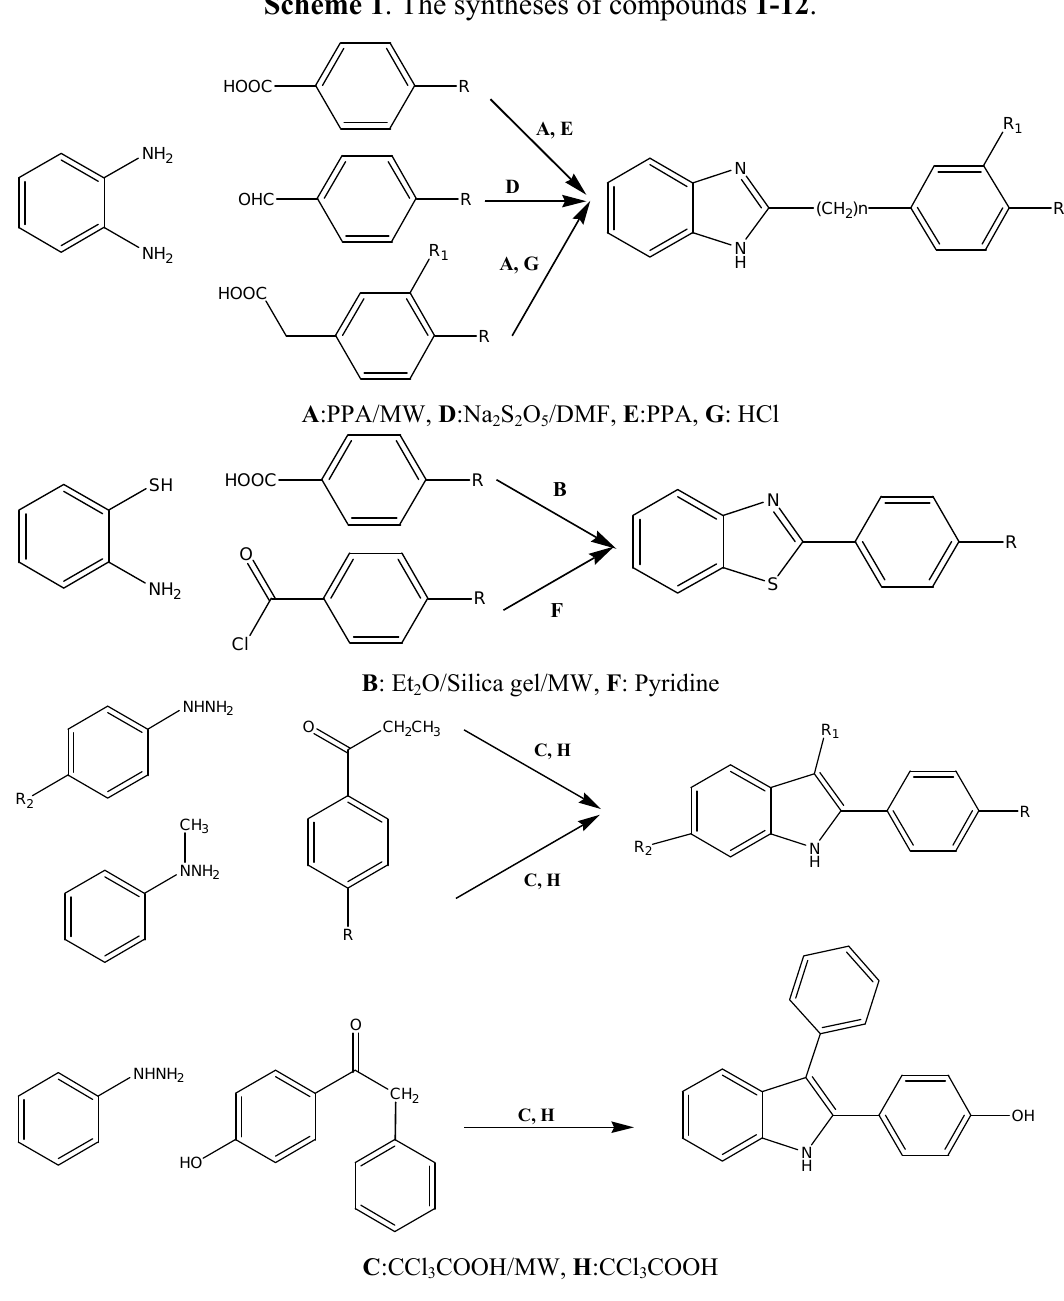
Scheme 1 . The syntheses of compounds 1-12